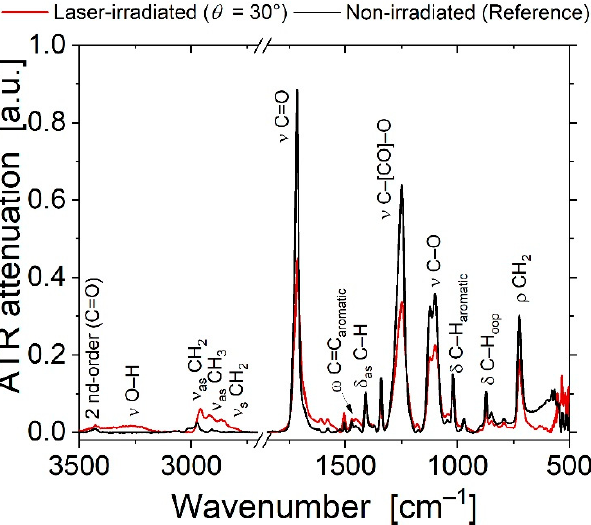
Figure 4. Attenuated total reflection Fourier transform infrared spectroscopy (ATR-FTIR) spectra of non-irradiated PET (black curve) compared to samples processed with LIPSS (type LSFL, red curve, θ = 30°, Φ = 5.7–6.2 mJ/cm 2 , N = 6000 pulses). Note the broken horizontal scale.